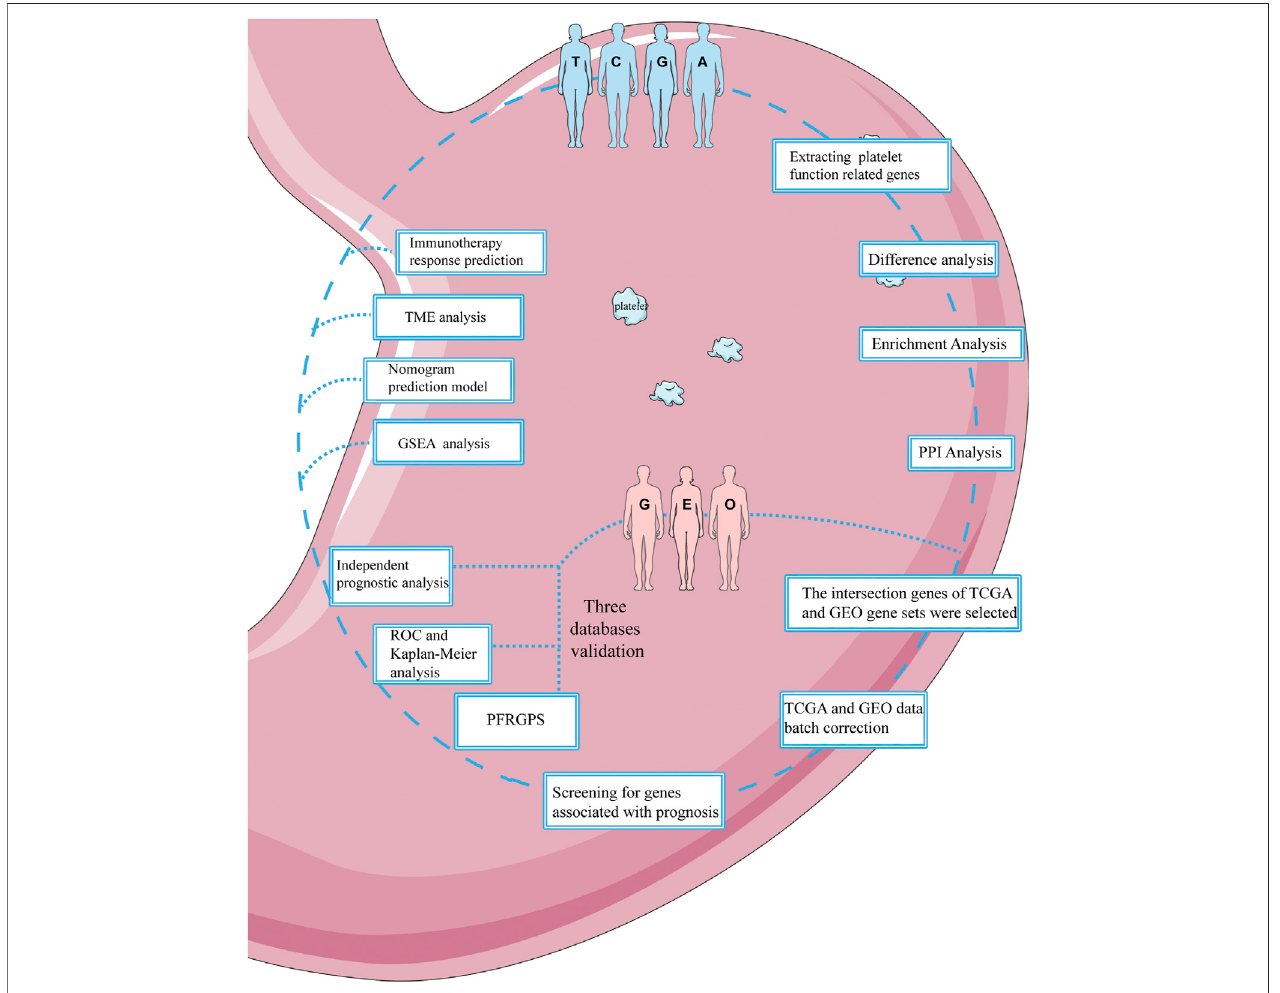
FIGURE 1 | Flowchart of this study. This fi gure was produced with the assistance of Servier Medical Art (https://smart.servier.com).